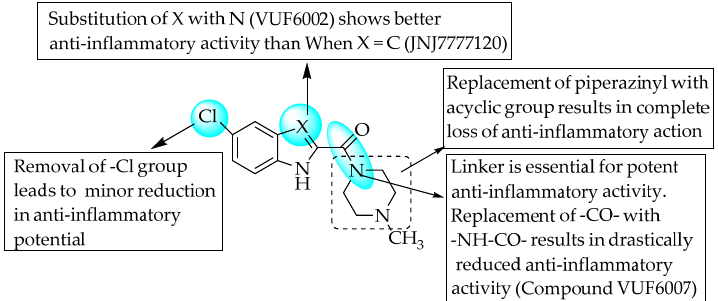
Figure 34 . SARs of piperazinyl-substituted benzimidazoles.